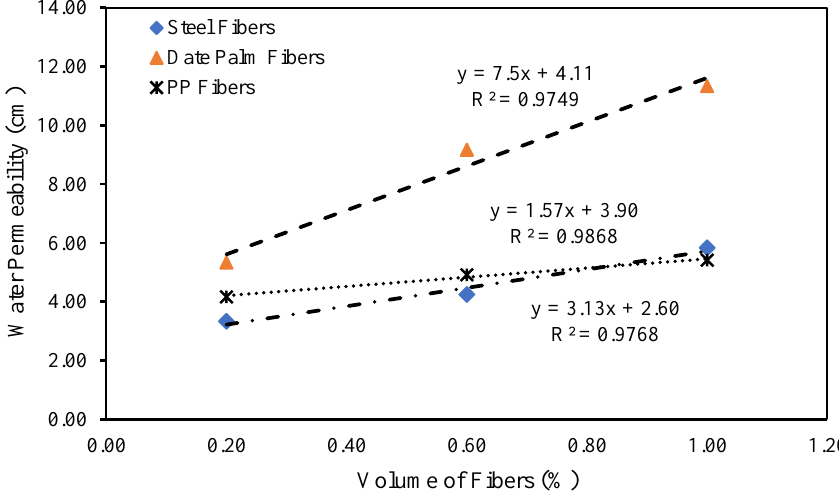
Figure 15. Relationship between the water permeability and volume fractions for different fibers.